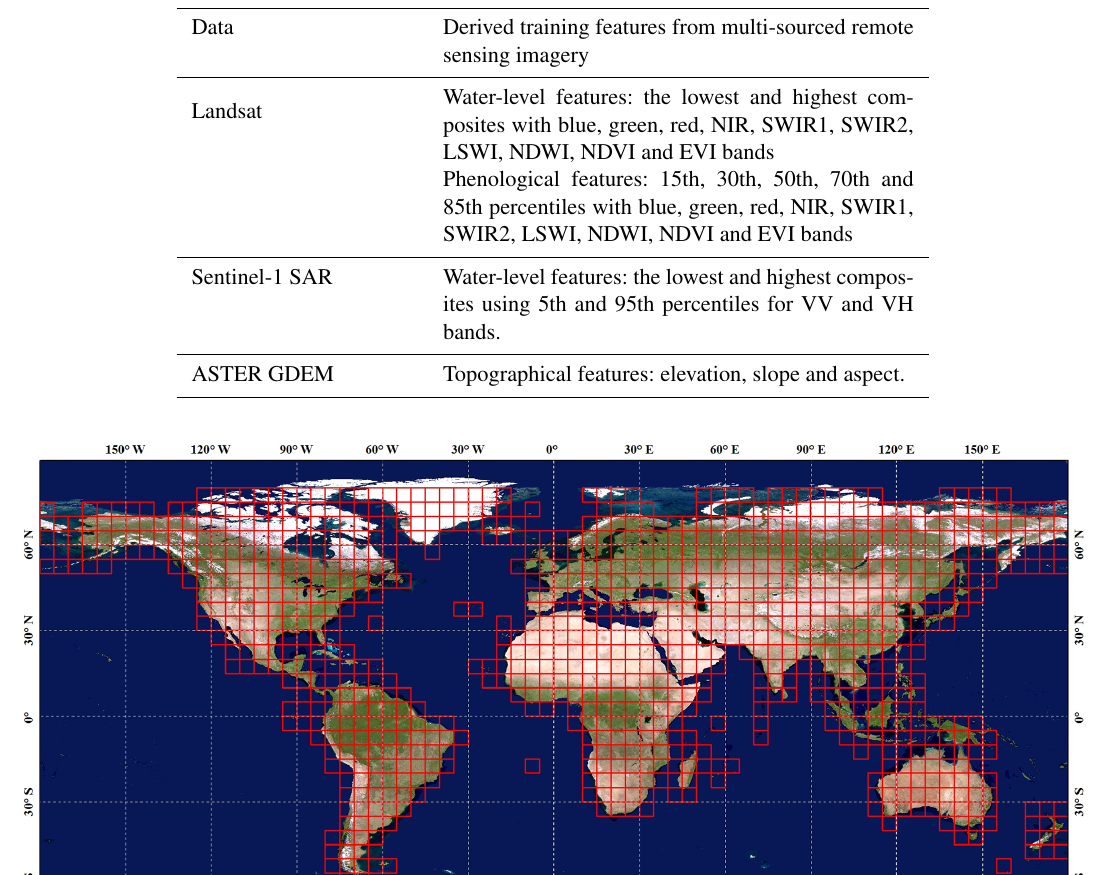
Table 3. The multi-sourced and multi-temporal training features for wetland mapping.